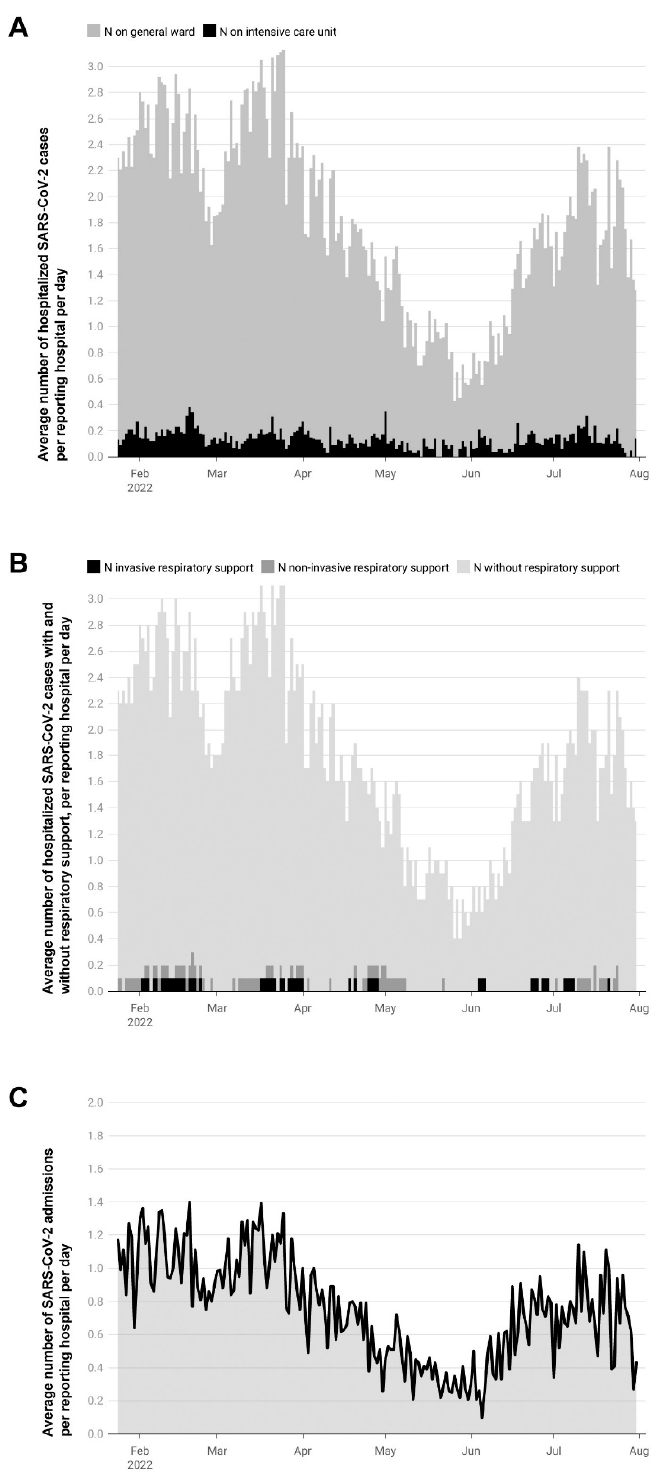
Figure 2. ( A ) Average number of hospitalized SARS-CoV-2 cases per reporting hospital per day. General wards and intensive care units are displayed separately. ( B ) Average number of hospitalized SARS-CoV-2 cases with and without respiratory support, per reporting hospital per day. ( C ) Average number of SARS-CoV-2 admissions per reporting hospital per day. All charts refer to hospitalized children and adolescents with SARS-CoV-2 in Germany, as reported to the DGPI’s ad hoc SARS-CoV-2 register from 24 January 2022, to 31 July 2022.